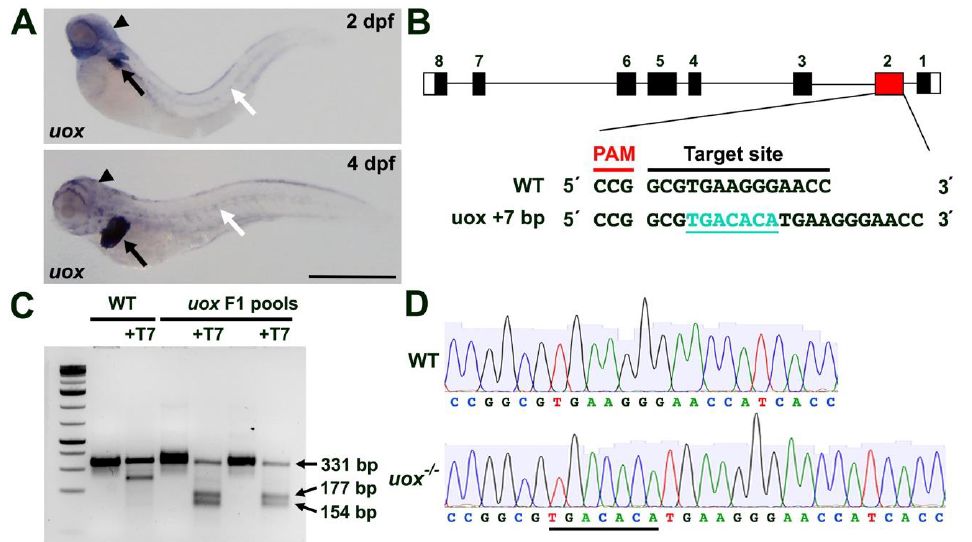
Figure 2. Generating a zebrafish uox mutant. ( A ) Expression of uox in 2 and 4 day post fertilization (dpf) larvae, as detected by WMISH (black arrows and arrowheads mark liver and head expression, respectively. White arrows mark horizontal myoseptum expression). ( B ) Schematic illustrating the intron (black line) and exon (black rectangles) structure of uox (with flanking UTRs as white rectangles). The position (red rectangle) of the CRISPR/Cas9 target site and the sequence are annotated, with the +7 indel mutation shown in green. ( C ) T7 endonuclease I assay (with and without T7 endonuclease) on pools of WT and F1 embryos. Successful editing is indicated by the cleavage products of 177 bp and 154 bp. ( D ) Sequencing chromatogram of amplicons from WT uox compared to a homozygous carrier of the +7 bp uox mutation (underlined). Scale bar: 500 µm.